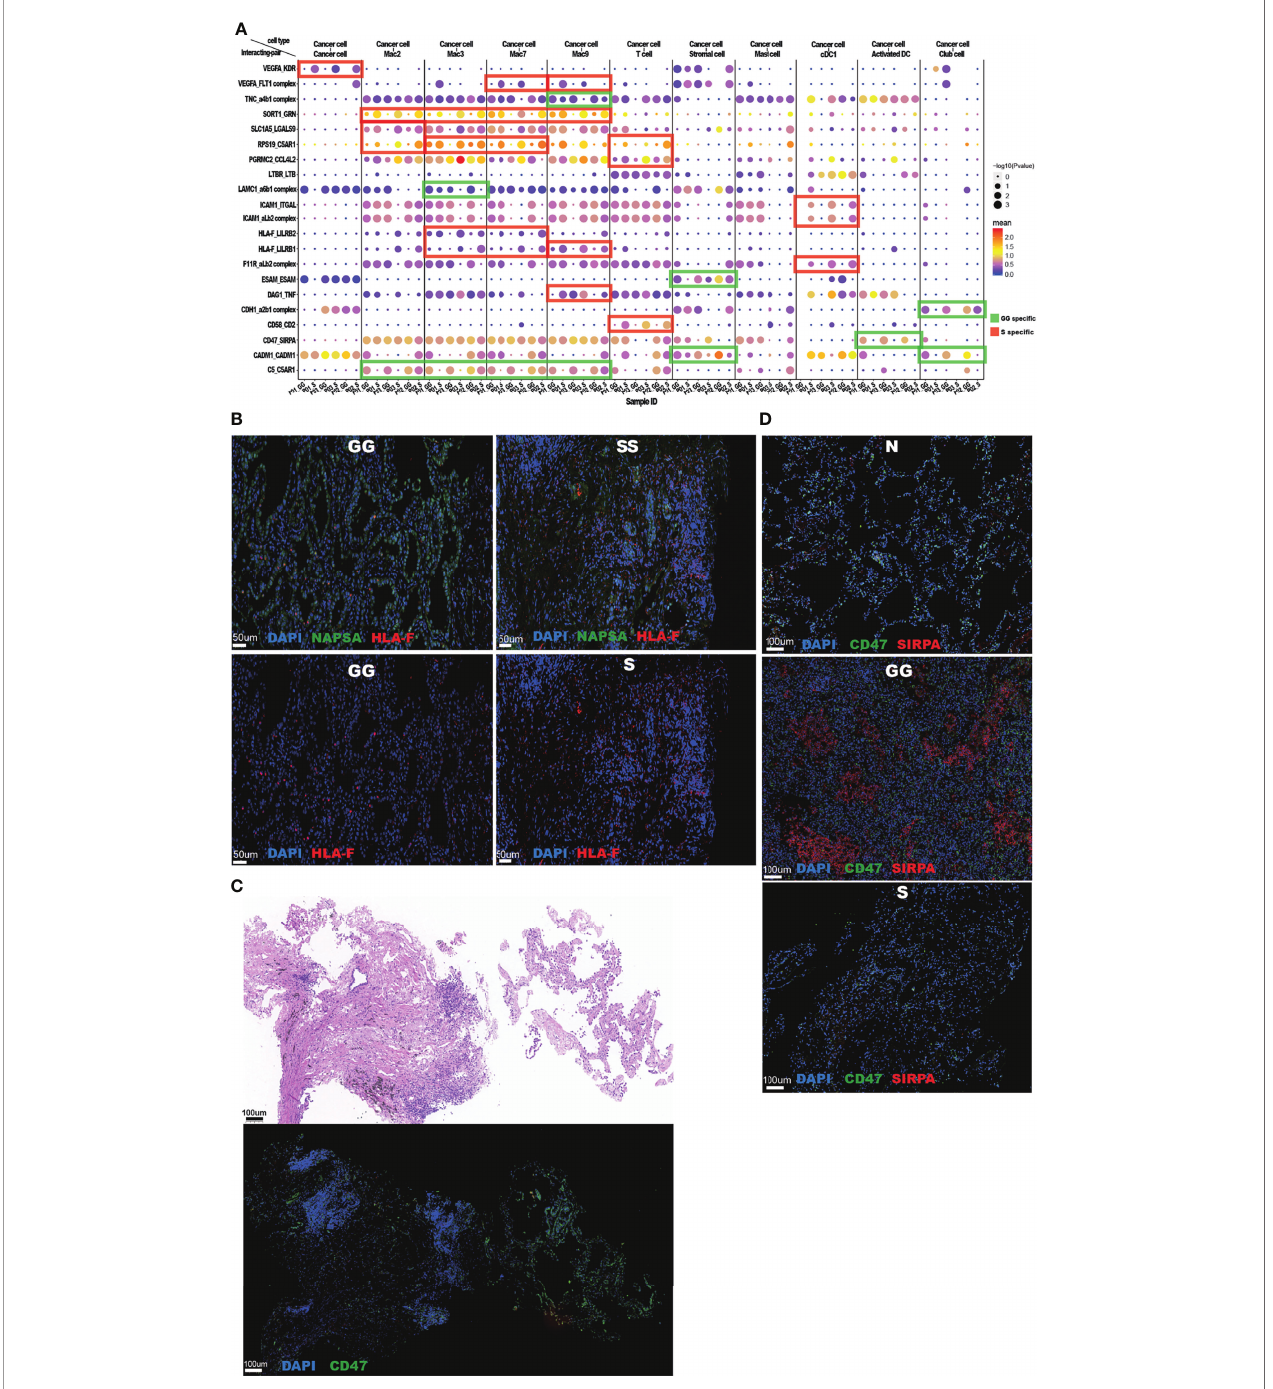
FIGURE 7 | Cancer cell-related interactions suggest different tumor development patterns in different mGGO components. (A) The bubble plot of cancer cell-related ligand – receptor pairs reveals S and GG preferences. The x-axis shows cell subsets, and the y-axis shows ligand – receptor pairs. Bubbles are annotated by − log 10 (P) (size) and mean expression level of ligand – receptor pairs (color). S and GG preference ligand – receptor pairs are highlighted by red and green shades, respectively. (B) IFA shows upregulation of HLA-F in cancer cells from S components in comparison with those from the GG components. Scale bars, 50 m m. (C) Consequent slices of mGGO show the S components (left) and the GG components (right) from an mGGO tissue. IFA on the bottom shows upregulation of CD47 in cancer cells from the GG components. Scale bars, 100 m m. (D) IFA shows the dramatic expression level of CD47 (green) and SIRPA (red) in the GG components (middle, labeled as GG) compared to normal lung (top, labeled as N) and S components (bottom, labeled as S). Scale bars, 100 m m. mGGO, mixed ground-glass opacity; S, solid; GG, ground glass; IFA, immuno fl uorescence